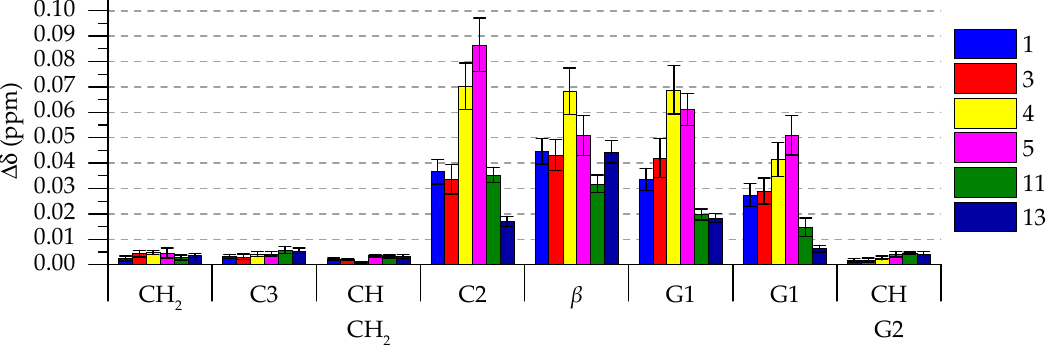
Figure 3. 1 H NMR chemical shift deltas ( ∆ δ , ppm) of E. coli lipid extracts in the presence of tellimagrandin I 1 , casuarictin 3 , tellimagrandin II 4 , pentagalloylglucose 5 , sanguiin H-6 11 , and lambertianin C 13 . The tannin numbering refers to Figure 1 and lipid proton assignations refer to Figure 5. Values are presented as ∆ δ (average values and standard error, n = 4).